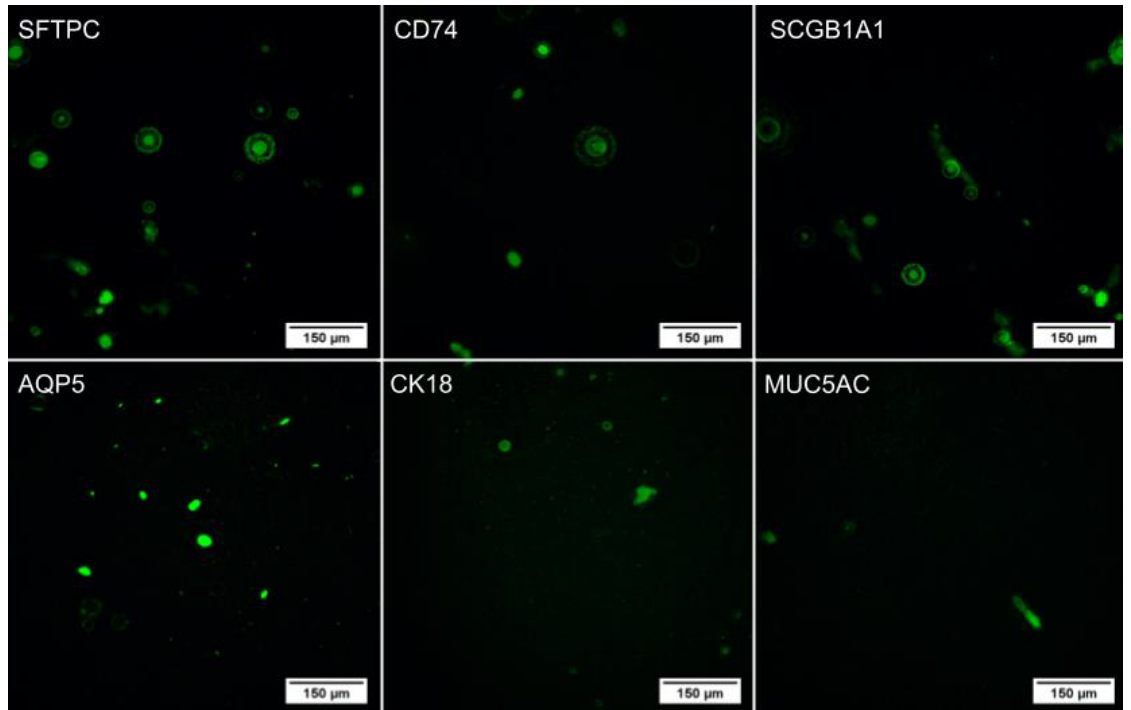
Figure 9. Immunocytochemistry of the 3D lung structures with FITC labeling specific proteins in green. Images obtained using a high-throughput microscope In Cell Analyzer 2000 (GE Healthcare ® , Chicago, IL, USA).